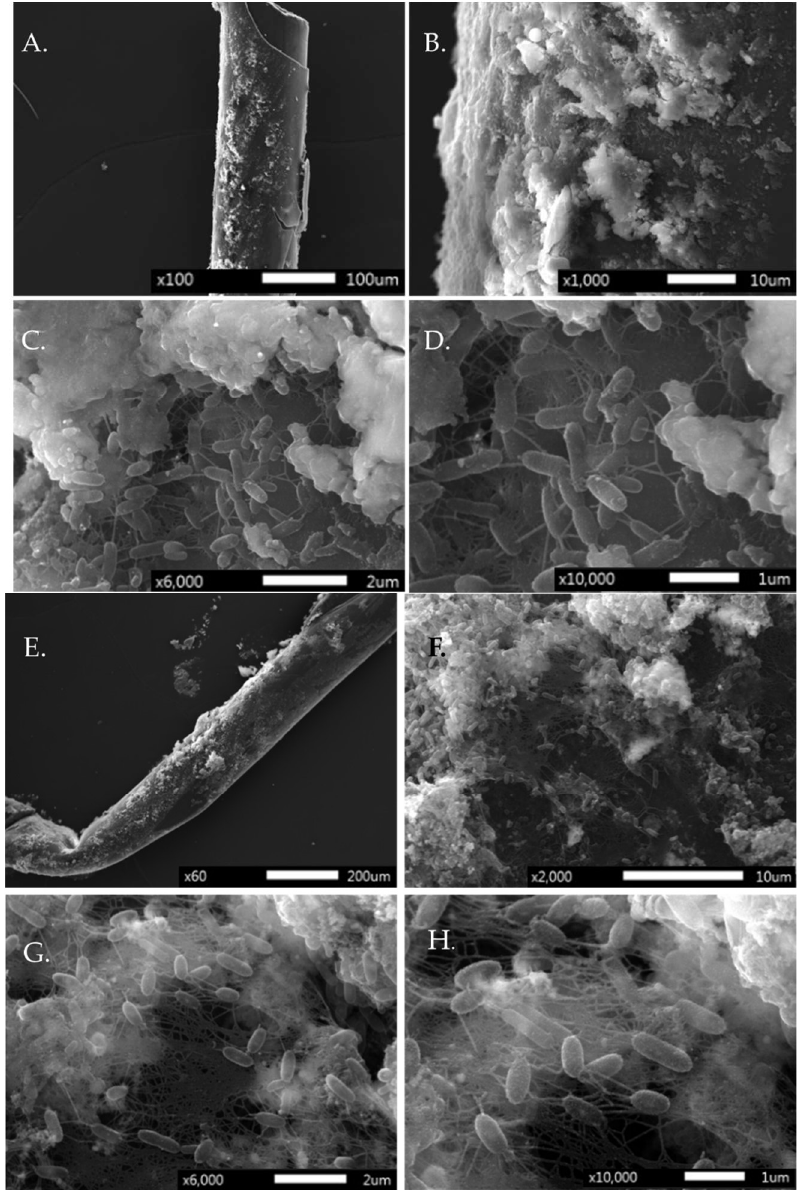
Figure 5. SEM images of hollow fibers incubated with enriched IC sludge samples. Sample (a) IC sludge with NaHCO 3 (100×, 1000×, 6000× and 10,000×) ( A – D ). Sample (b) IC sludge with C 2 H 3 NaO 2 (60×, 2000×, 6000× and 10,000×) ( E – H ).